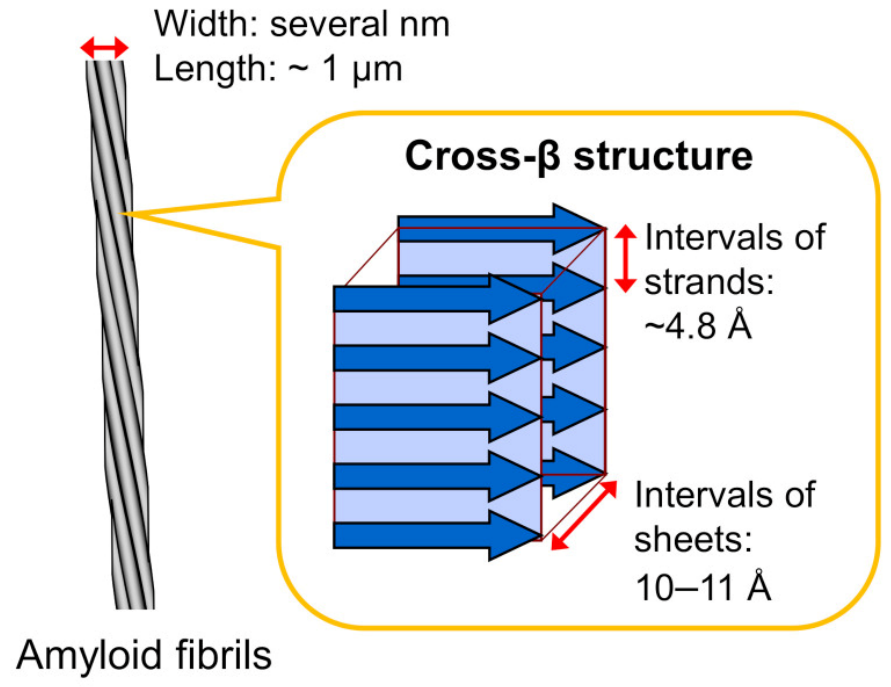
Figure 3. Schematic illustration of an amyloid fibril. Amyloid fibrils typically show unbranched morphology, which consists of several laterally bundled protofilaments a few nanometers in width and around a micrometer in length. Proto fi laments show a peculiar cross- β structure, where β - strands are stacked perpendicular to the long axis of the fi bril. Reprinted with permission from Chatani E. et al., 2021 [41].